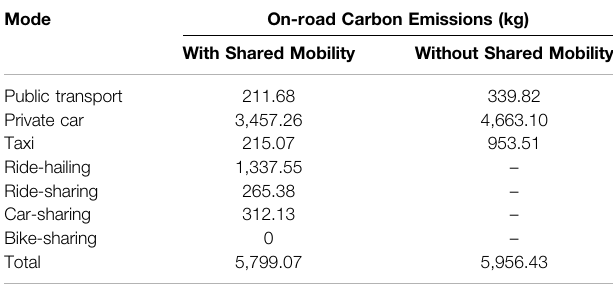
TABLE 6 | On-road carbon emissions with and without shared mobility in the context of COVID-19.